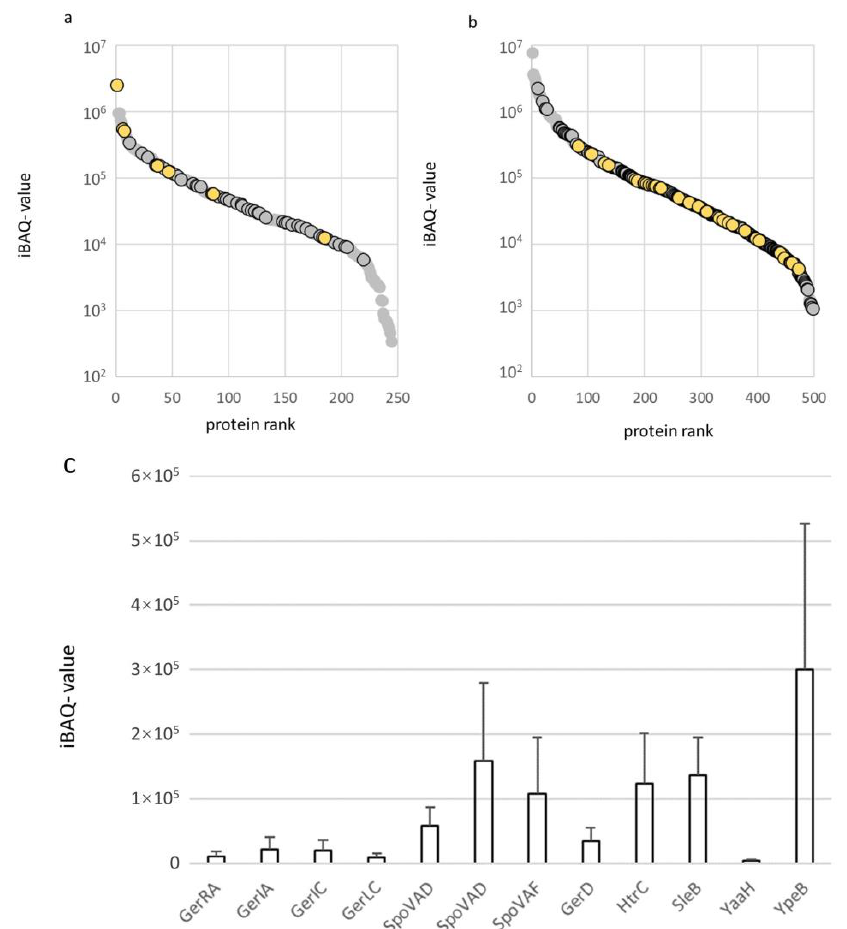
Figure 4. Abundance of membrane annotated proteins in the cell and spore membrane fractions. Membrane annotated proteins are shown ranked according to iBAQ values for spore inner mem- brane ( a ) and cell membrane preparations ( b ). Circles with a solid border mark protein exclusively identified in spores and cells, yellow circles mark uncharacterized proteins. ( c ) Proteins related to germination of bacillus spores, mean iBAQ values of 3 replicates are shown, error bars denote the standard error of the mean.